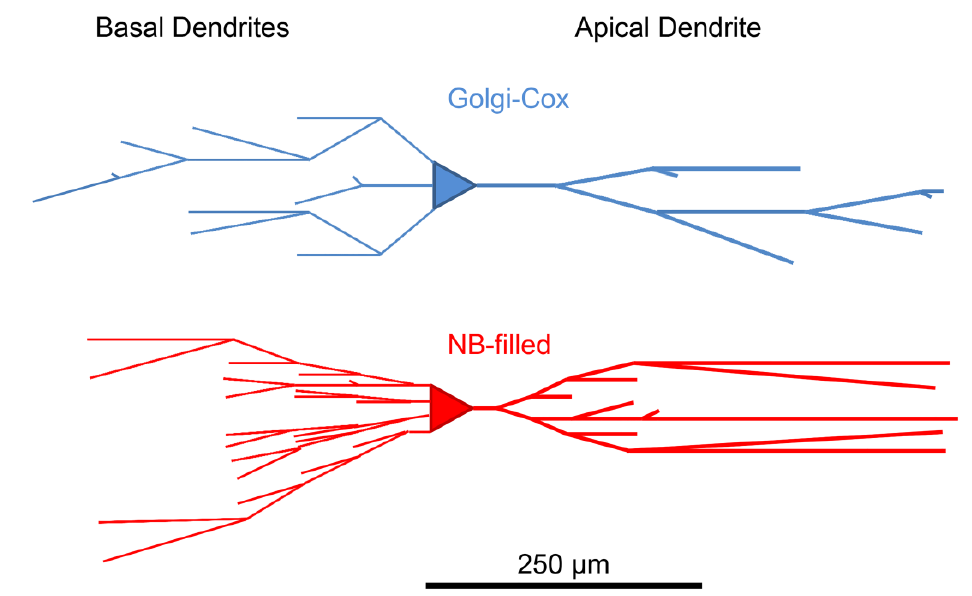
Figure 3. BLA principal neuron dendrogrammes of branch order segment number and length. Dendrogrammes show the mean number of apical and basal dendrites per branch order and the mean segment length per branch order in Golgi–Cox (blue) and NB-filled (red) BLA principal neurons. Note that the maximum apical terminal distance is unchanged between the two techniques.